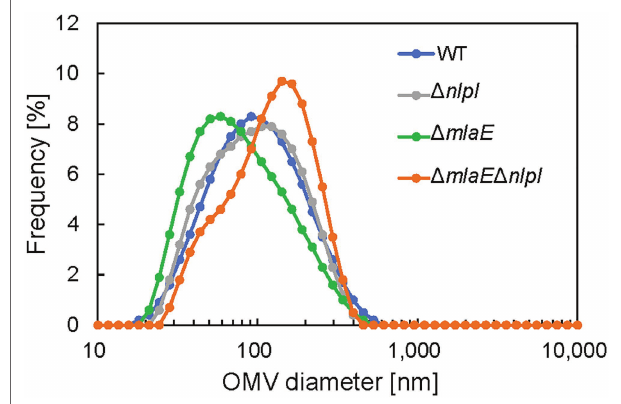
FIGURE 1 | Distribution of outer membrane vesicle (OMV) diameter in each Escherichia coli strain. The OMV samples were collected after 24 h in culture. The diameter of the OMVs was determined using dynamic light scattering